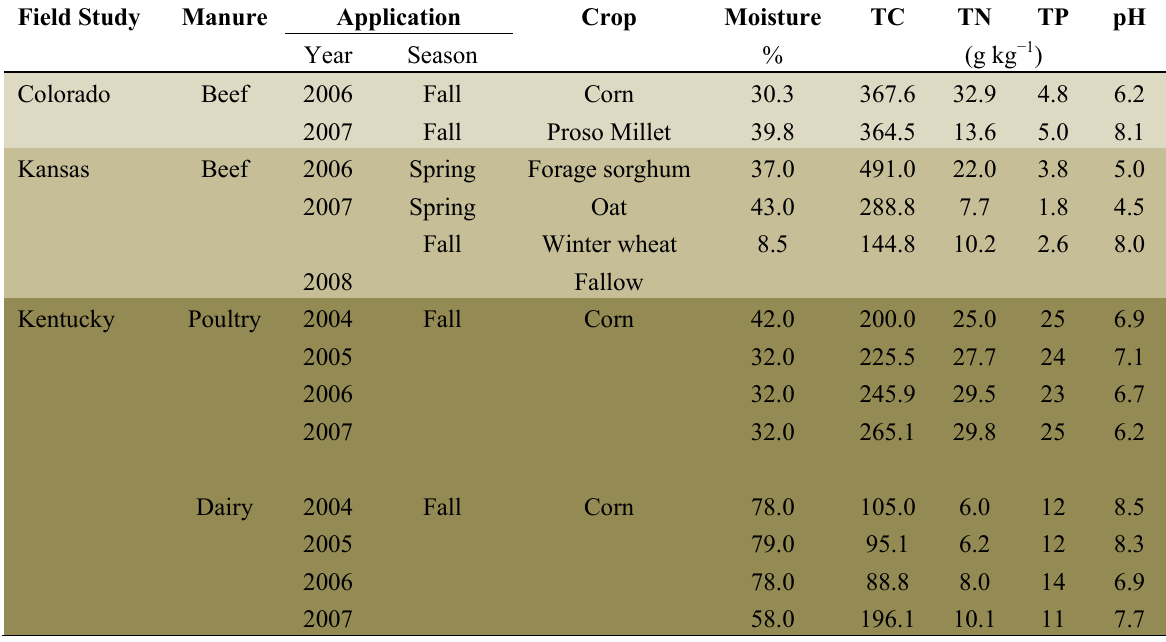
Table 1. Selected properties of the manure applied to the field